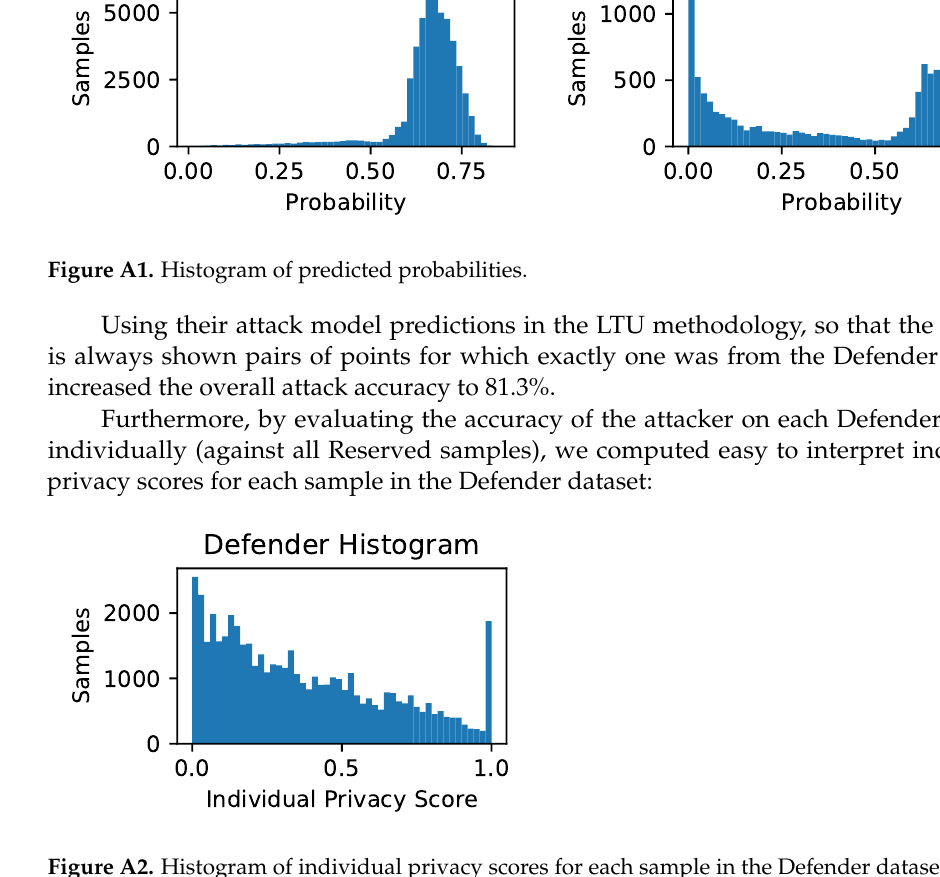
Figure A2. Histogram of individual privacy scores for each sample in the Defender